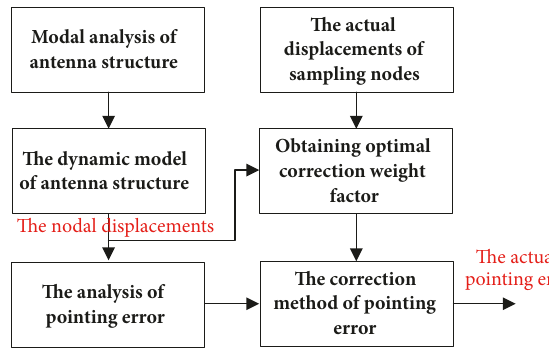
Figure 1: The flow chart of the correction method.